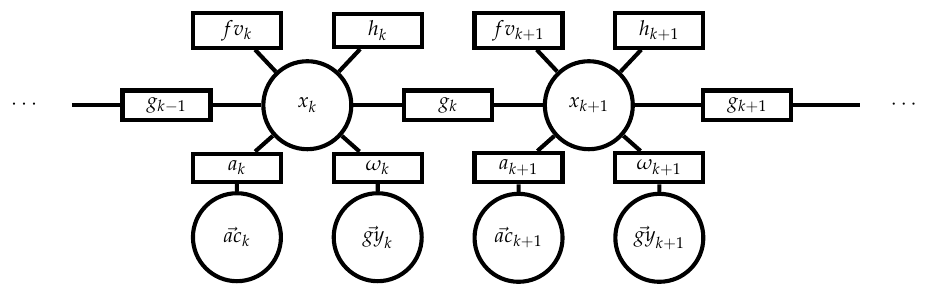
Figure 3. Ref. [11] The optimization problem as a factor graph. (cid:126) ac k and (cid:126) gy g k the dynamic model (8), a k the acceleration function (7), ω k the angular rate function (6), fv k the forward velocity prior (9) and h k the height-map prior